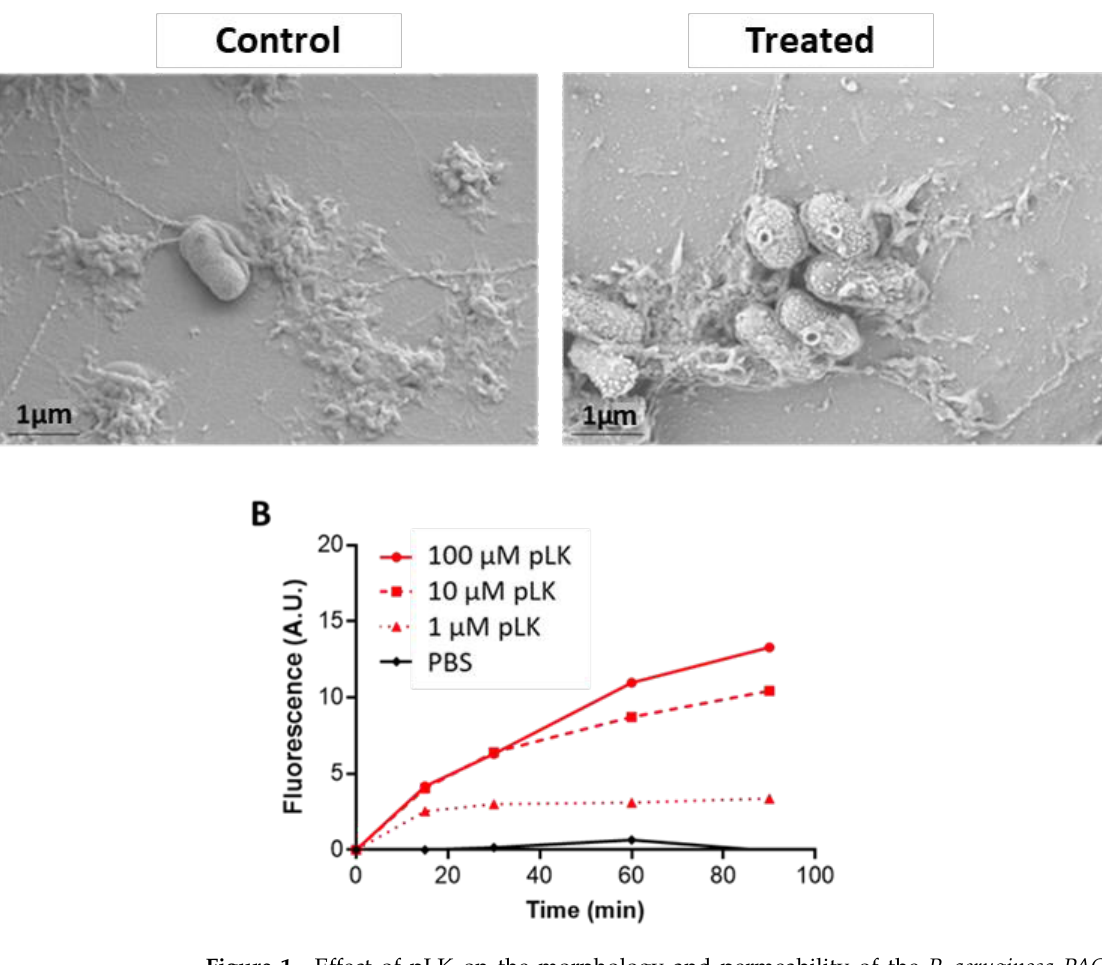
Figure 1. Effect of pLK on the morphology and permeability of the P. aeruginosa PAO1 strain. ( A ) Scanning electron micrographs of P. aeruginosa exposed or not to 10 µ M pLK. ( B ) Effect of pLK on P. aeruginosa membrane polarization. Results are expressed in relative intensity fluorescence observed at 670 nm compared to the negative control (PBS). Values are mean ± SEM of three independ- ent determinations.